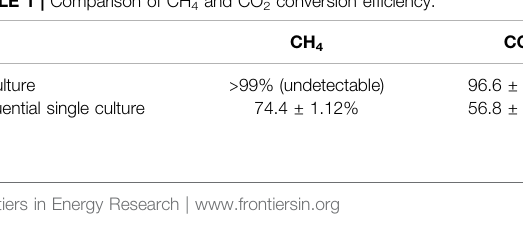
TABLE 1 | Comparison of CH 4 and CO 2 conversion ef fi